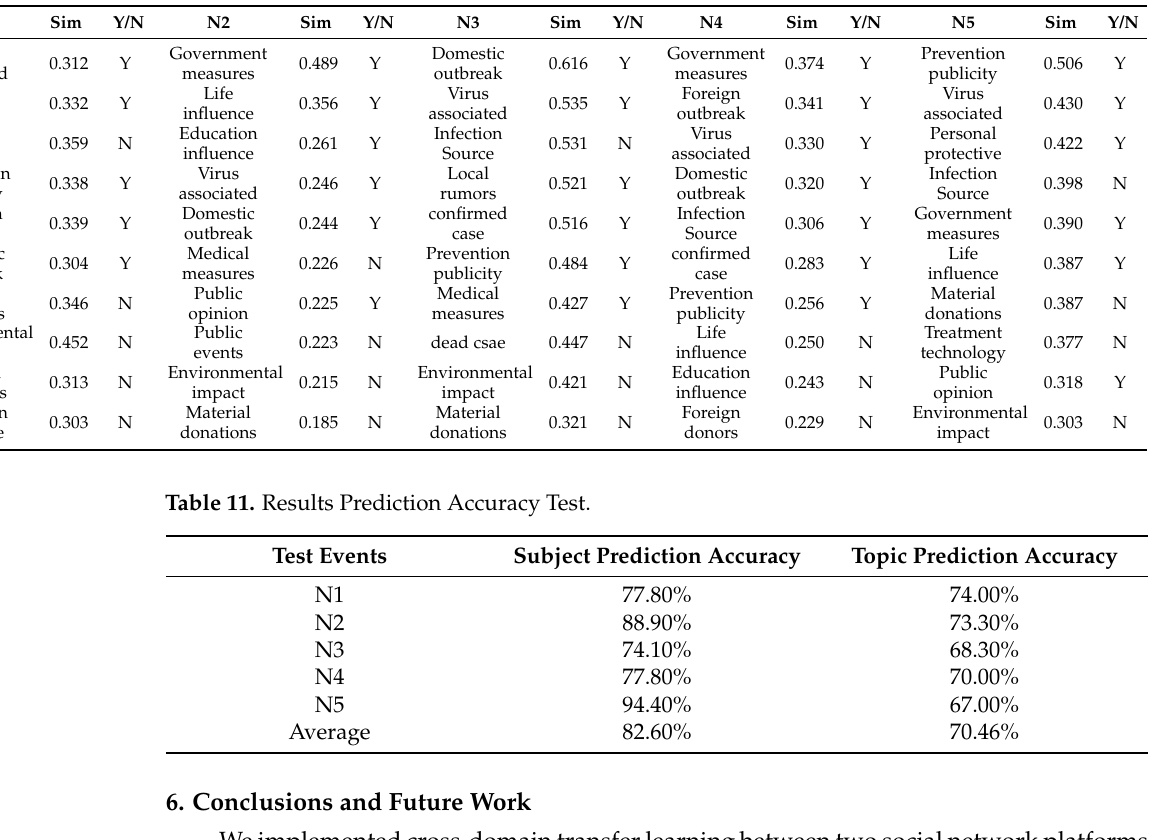
Table 10. N1–N5 test the target domain generalization topic prediction results of events.